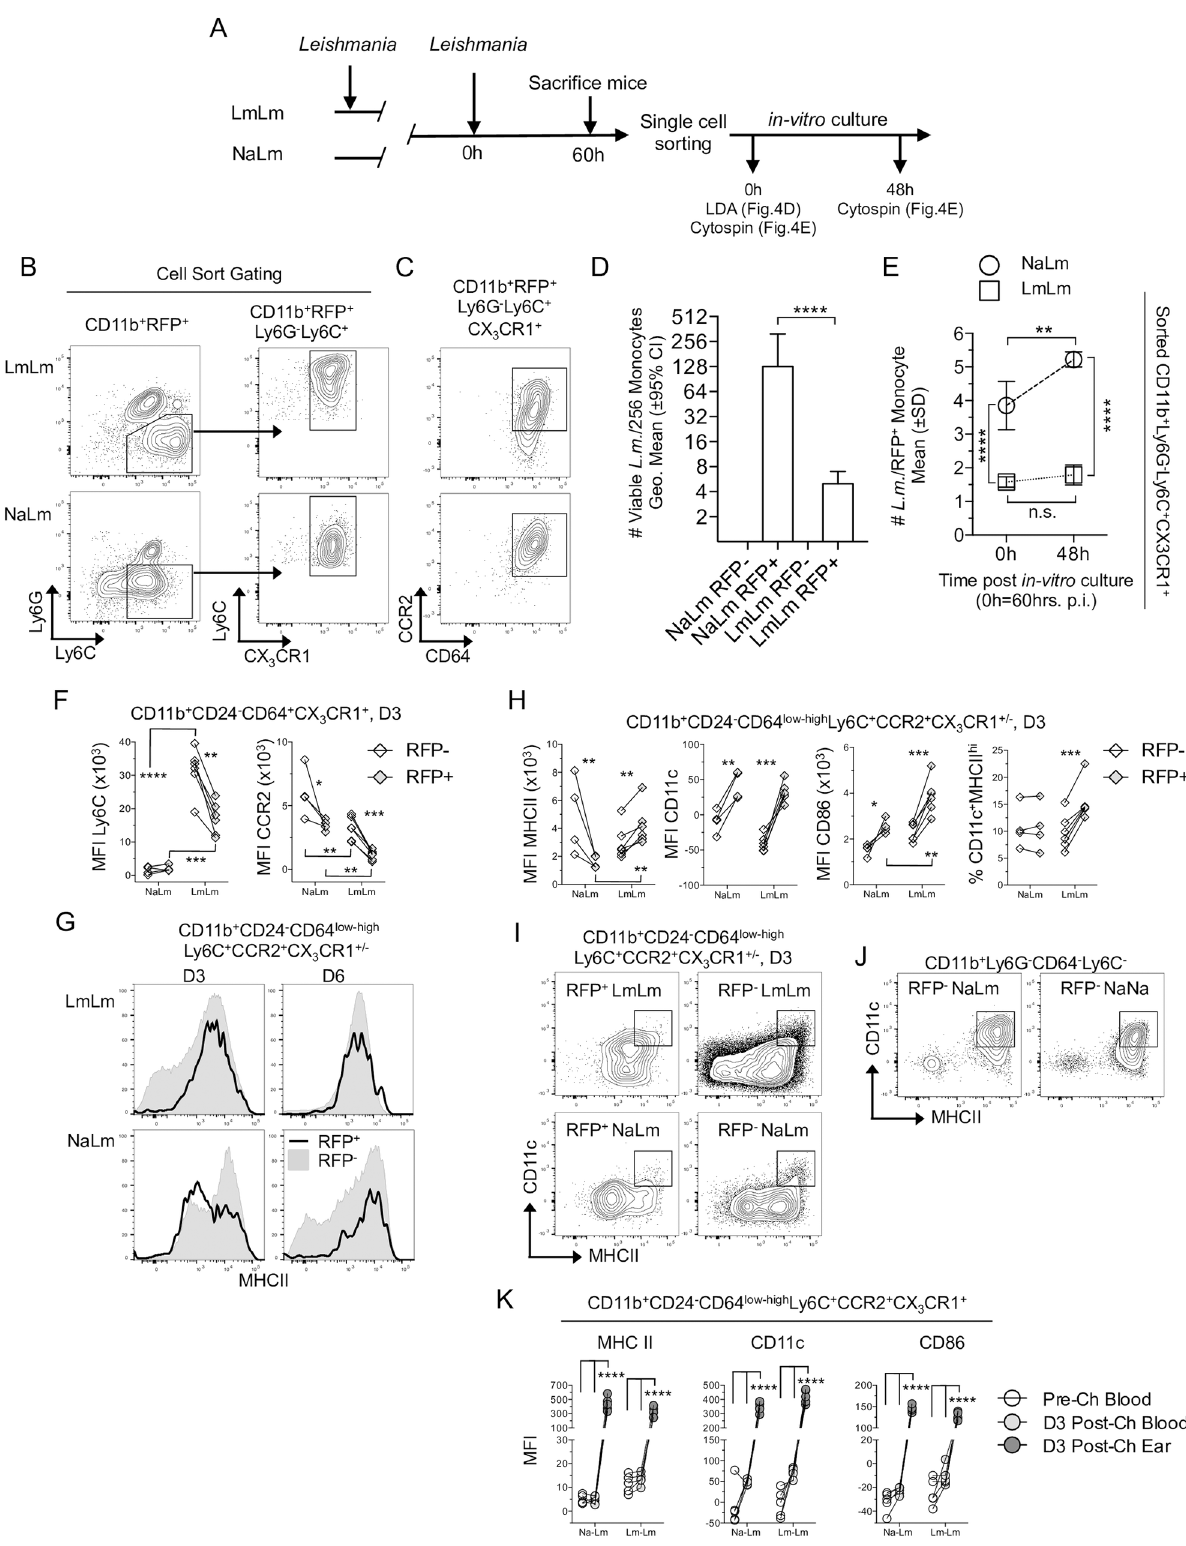
Fig 4. Inflammatorymonocytesareactivated and mediateparasite killing at sitesof secondaryinfection. Na ï veCX 3 CR1-gfpmice (NaLm)or micewitha chronicprimaryinfection(LmLm)werechallenged inthe earwith2x10 5 L. major -RFP. (A) Schematicof